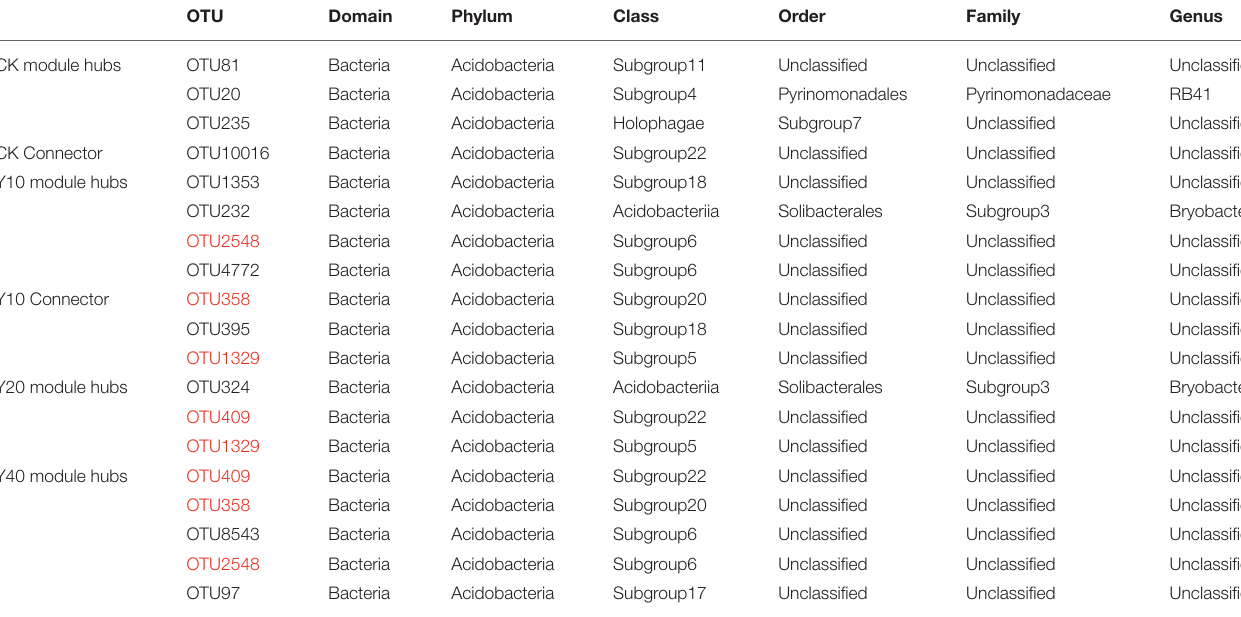
TABLE 6 | Taxonomy information of keystone operational taxonomic units (OTUs) of Acidobacteria